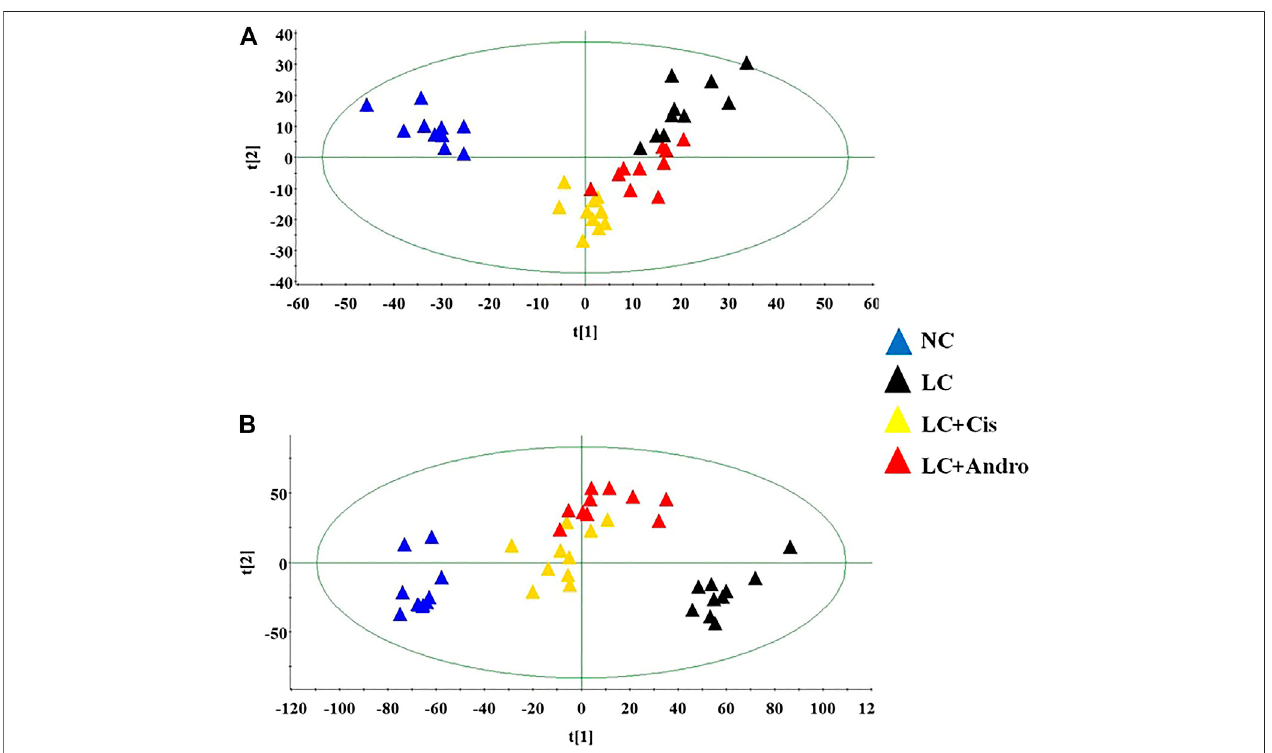
FIGURE2| ThescoreplotofthePCAmodelamongNC,LC,LC+CisandLC+Androgroupinpositiveionmode (A) ;ThescoreplotofthePCAmodelamongNC, LC, LC + Cis and LC + Andro group in negative mode (B) .